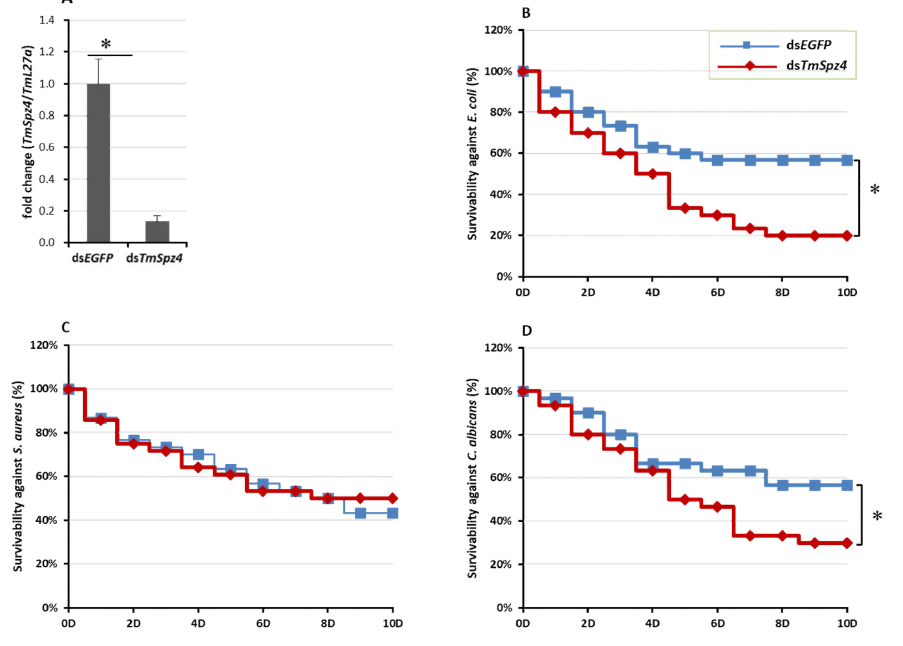
Figure 4. Effect of ds TmSpz4 on the survival of T. molitor larvae. The silencing efficiency of dm TmSpz4 was measured by qRT-PCR at 5 days post-injection ( A ). Then, the TmSpz4 -silenced larvae were injected with E. coli ( B ), S. aureus ( C ), or C. albicans ( D ) and survival was monitored. ds EGFP -injected larvae were included as a negative control. The data are an average of three biologically independent replicate experiments. Asterisks indicate significant differences between ds TmSpz4- and ds EGFP- injected groups ( p < 0.05). Statistical analysis of survival analysis was carried out based on Kaplan-Meier plots (log-rank chi-square test; * p <